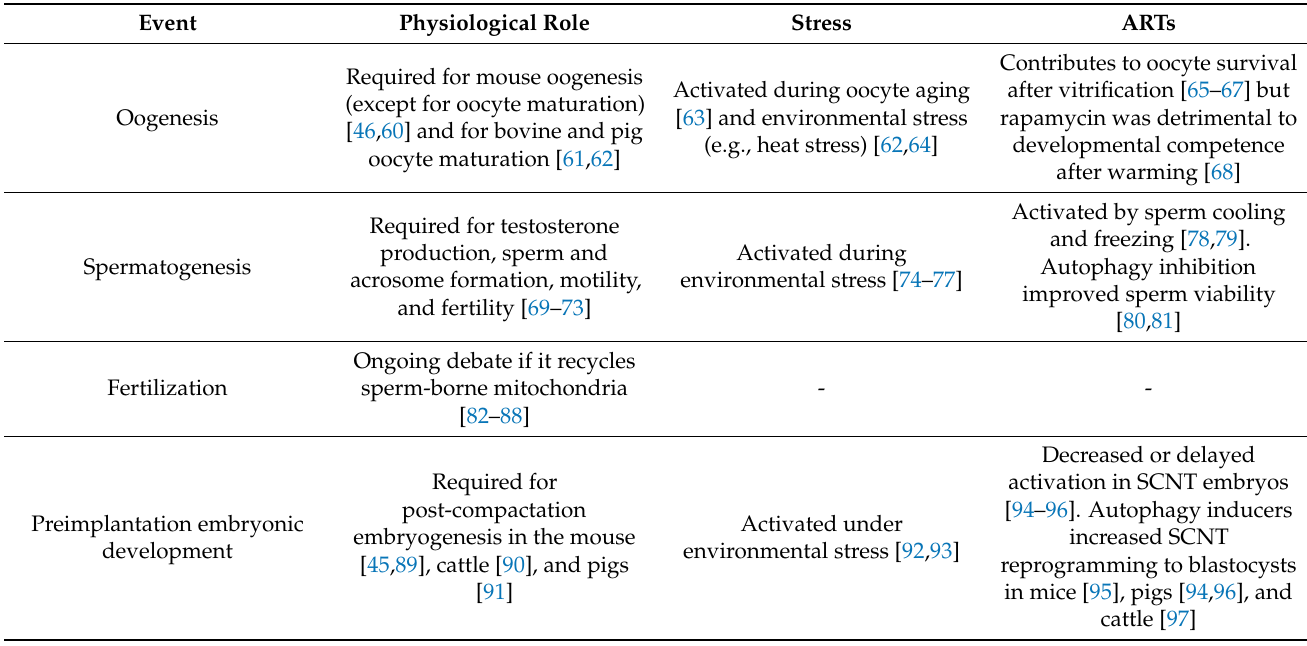
Table 1. Context-dependent roles of autophagy from gametogenesis to preimplantation embryonic development.